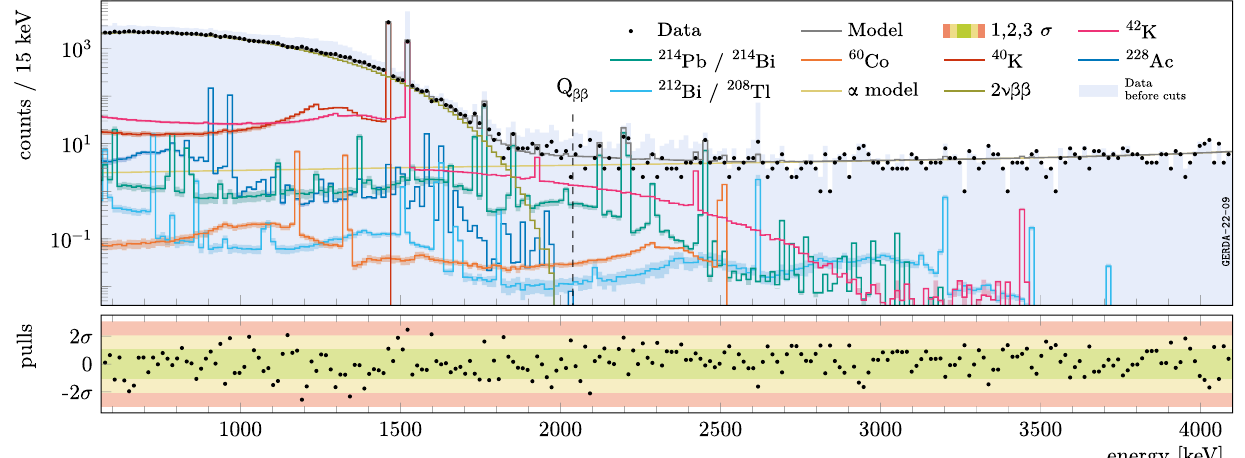
Fig. 8 Background decomposition of the first 61.4 kg years of data from Gerda PhaseIIsurviving the LAr veto cut (black dots). The veto modelisappliedtotheexistingbackground pdfs beforethecut[28]fold- ing in the probability map ξ( (cid:6) x ) . Data before the cut is shown as a light